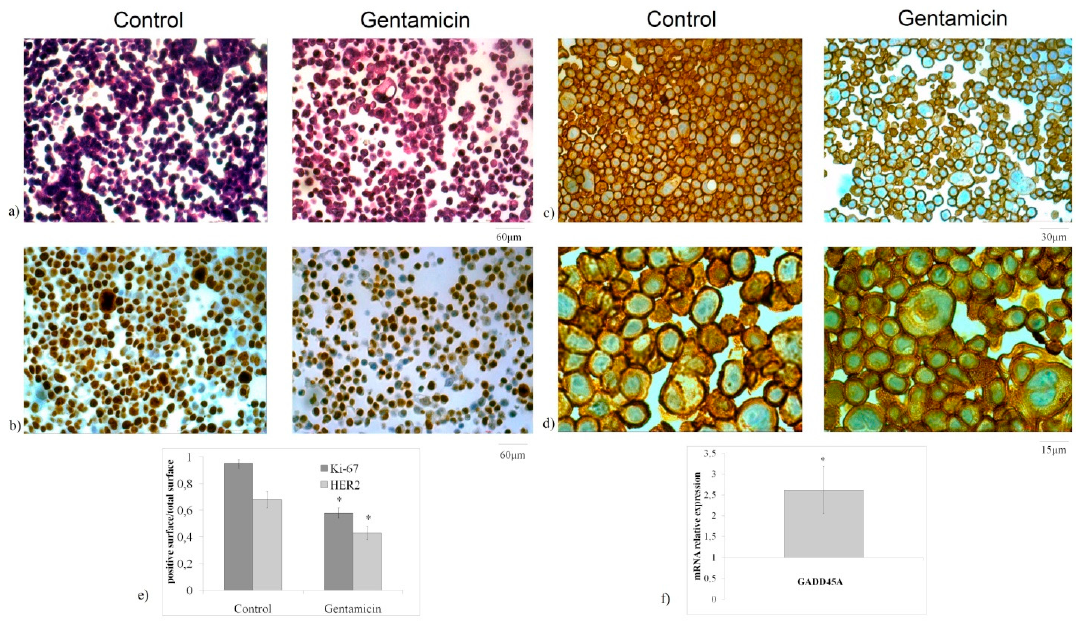
Figure 2. Effect of gentamicin after 24 h from treatment. ( a ) Cell morphology by hematoxylin–eosin staining; ( b ) MIB-1 immunohistochemistry staining; ( c , d ) HercepTest immunostaining. 10 × magnification ( a , b ), 20 × magnification ( c ), and 40 × magnification ( d ); ( e ) densitometric analysis; ( f ) GADD45A gene expression, data are referred to the GM-untreated sample (control) set at 1. GAPDH expression was used as a housekeeping gene. RT-PCR analysis was performed in control and experimental NCI-N87 cells collected 24 h after 1.5 mM GM treatment. The data represent the mean ± SD of three independent experiments performed in duplicate (significance, * p < 0.001 versus control sample).